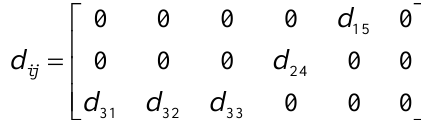
Figure 1 is schematic picture of a PVDF film. The sensitivity of the PVDF film depends on the direction of measurement. The coefficients d direction 1, 2, 3, respectively and − d shearing strain coefficient of the film sides in the direction 1, 2, respectively. For the commercially available PVDF film, the piezoelectric shearing strain coefficients are smaller than the piezoelectric strain coefficients about two orders of